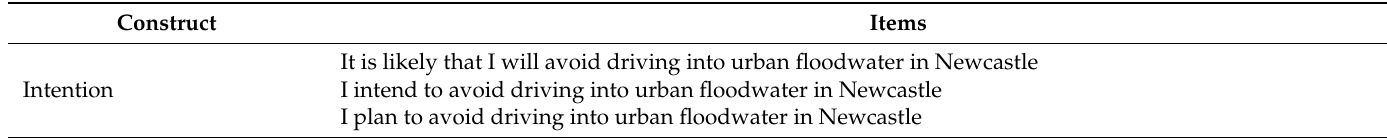
Table 1. Items and response scales for social cognitive construct